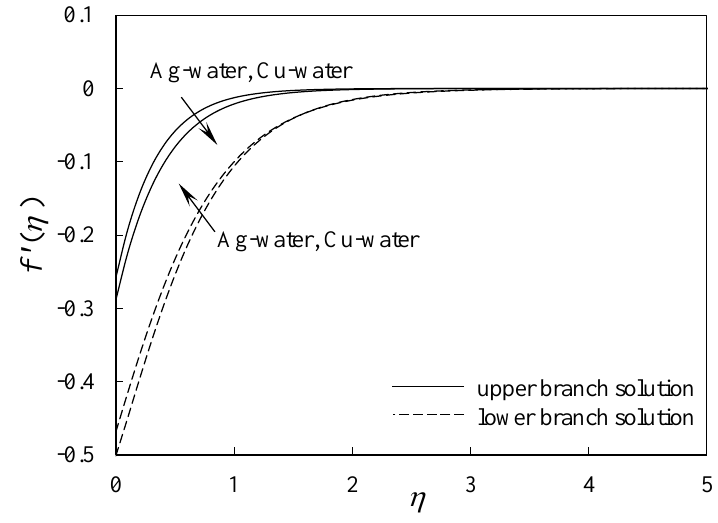
Figure 20. Velocity profiles f (cid:48) ( η ) when λ = − 1, N = 1, K = 1, and M = 1.